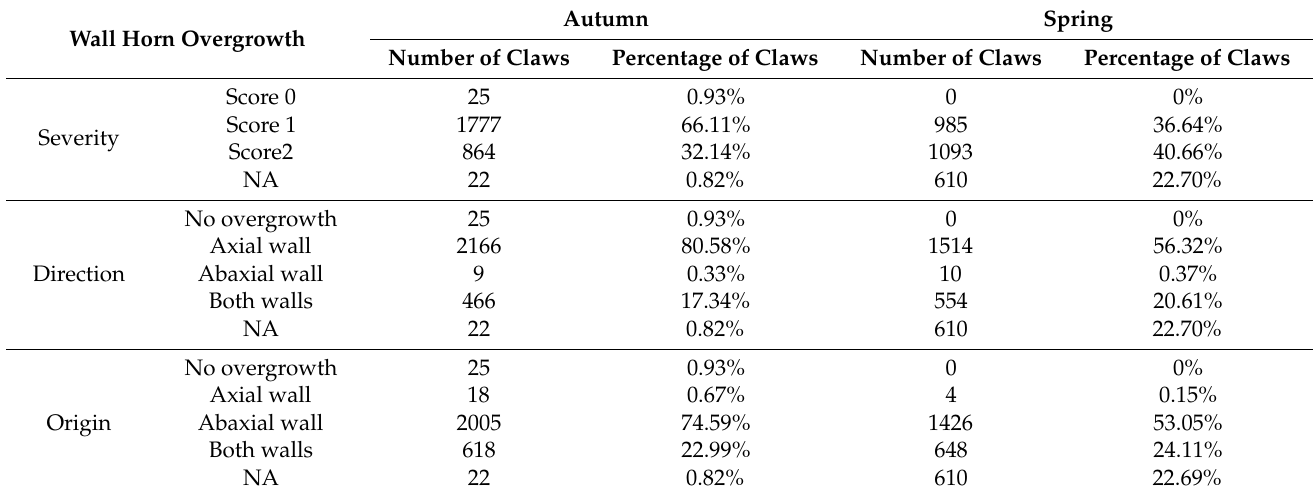
Table 5. Severity (score 0, 1 or 2), direction (no overgrowth, axial, abaxial or both walls) and origin (no overgrowth, axial, abaxial or both walls) of wall horn overgrowth recorded in autumn and spring (NA = information not available). Wall Horn Overgrowth